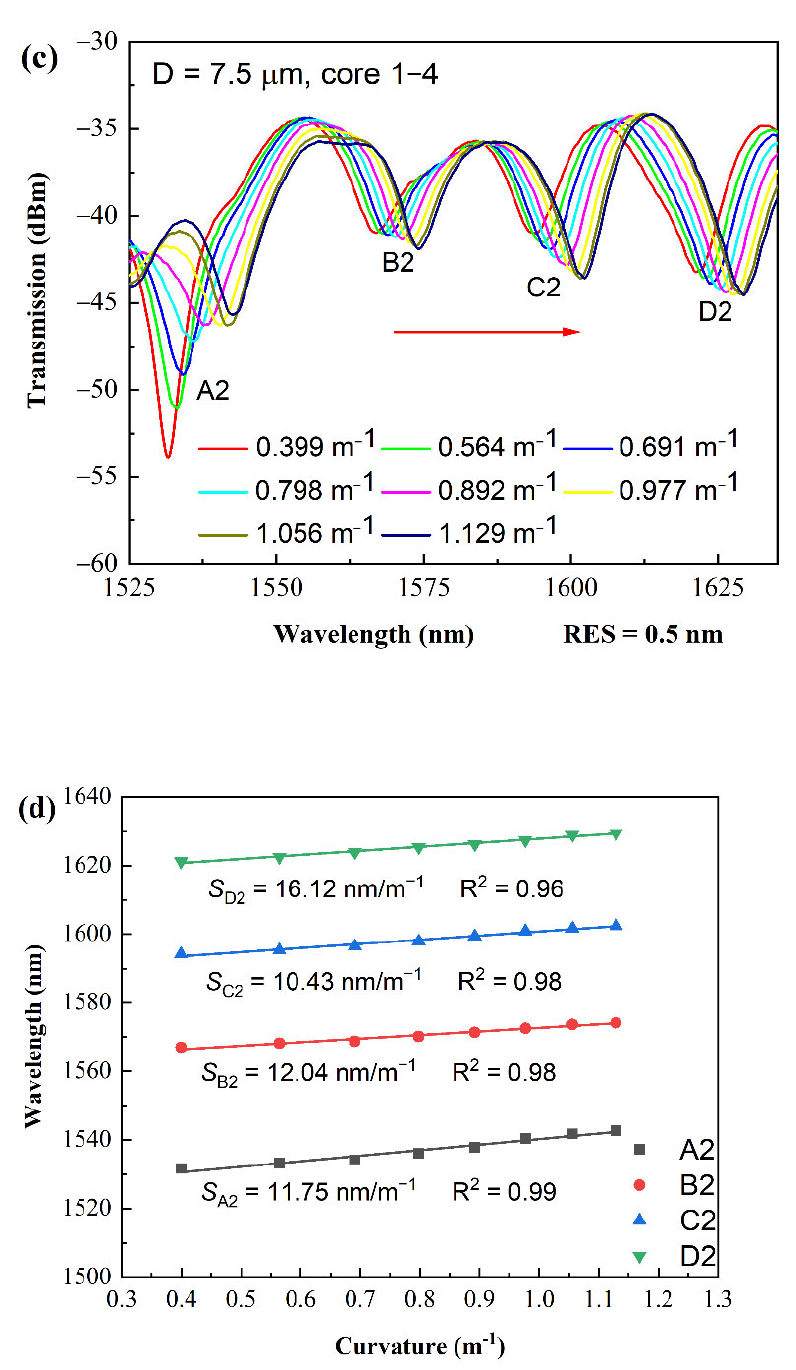
Figure 4. Spectral responses of the tapered FCF interferometer under different tensile bending in ( a ) TFCF ‐ 2 and ( c ) TFCF ‐ 3. Linear fitting curves of the dip wavelength shifts and the coefficients of determination (R 2 ) of linear fitting in ( b ) TFCF ‐ 2 and ( d ) TFCF ‐ 3.